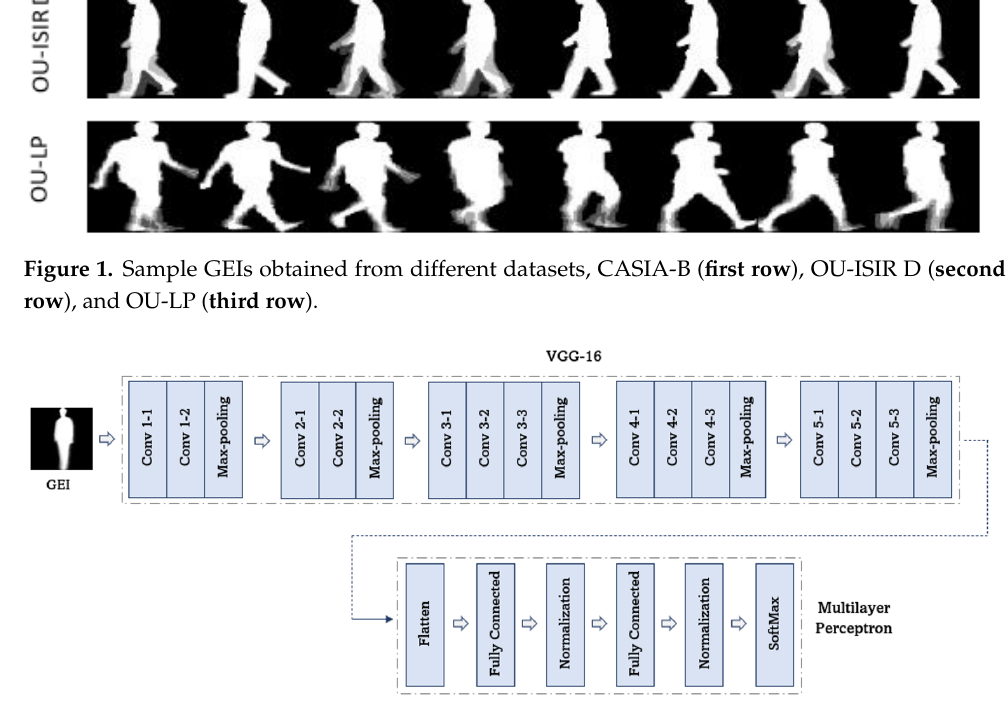
Figure 2. The architecture of the proposed VGG16-MLP